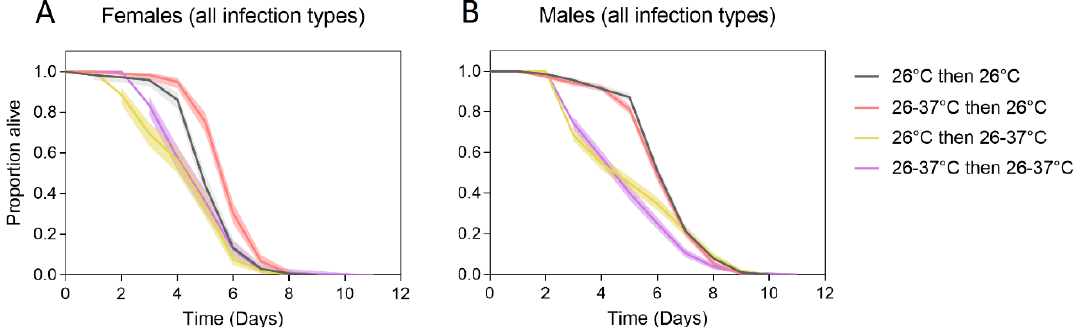
Figure 2. Adult starvation tolerance of female ( A ) and male ( B ) Ae. aegypti that were reared under different temperature regimes across two generations. Mosquitoes were reared at 26 ◦ C in both generations (gray lines), 26–37 ◦ C in both generations (purple lines), 26–37 ◦ C in the first generation and 26 ◦ C in the second generation (red lines) or 26 ◦ C in the first generation and 26–37 ◦ C in the second generation (yellow lines). Data for all Wolbachia infection types were pooled in these comparisons. Solid lines represent the proportion of adults alive each day, while shaded areas are 95% confidence intervals.